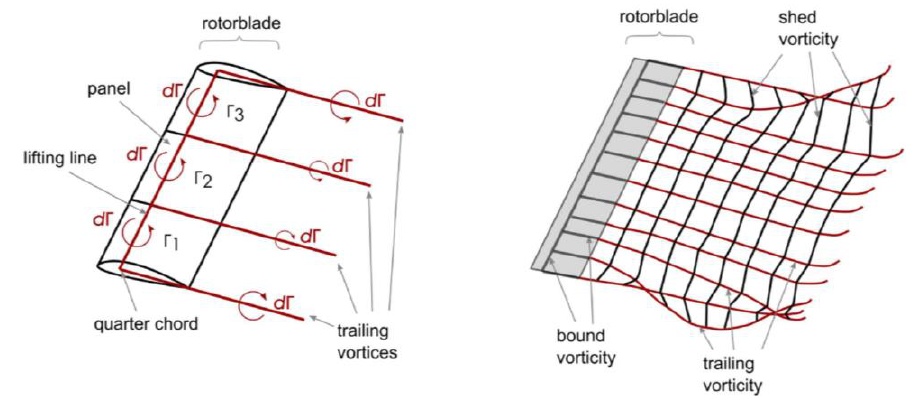
Figure 2. Illustration of blade and wake modeling with the LLFVW algorithm [25].